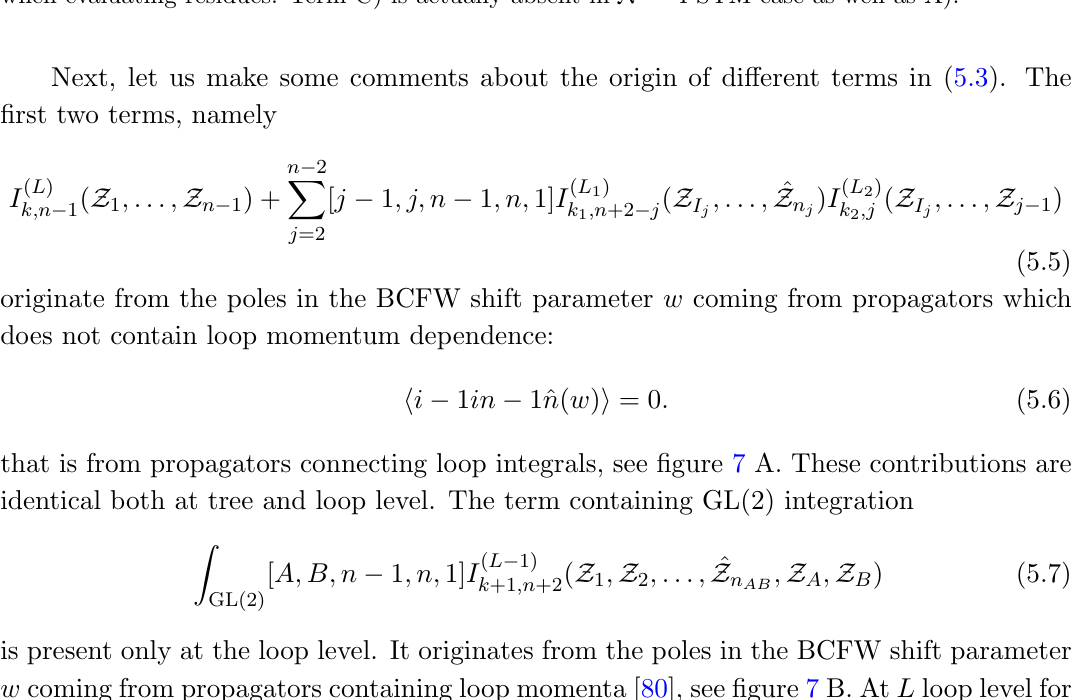
= 4 SYM case as well as N